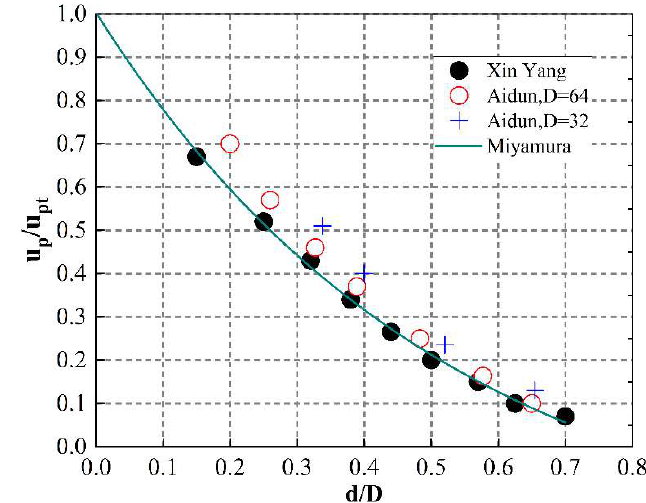
Figure 6. Diagram of wall effect with the diameter.